Question: Does the figure show an increasing or a decreasing trend?
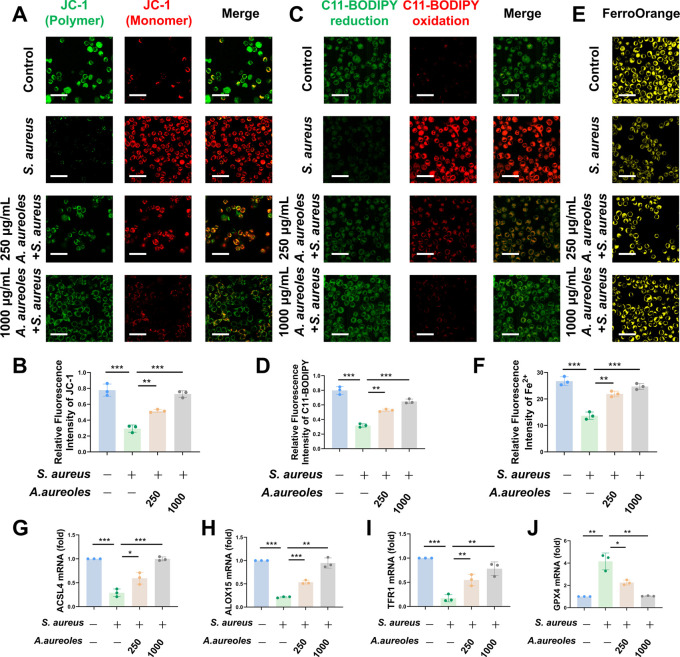
Answer: increasing